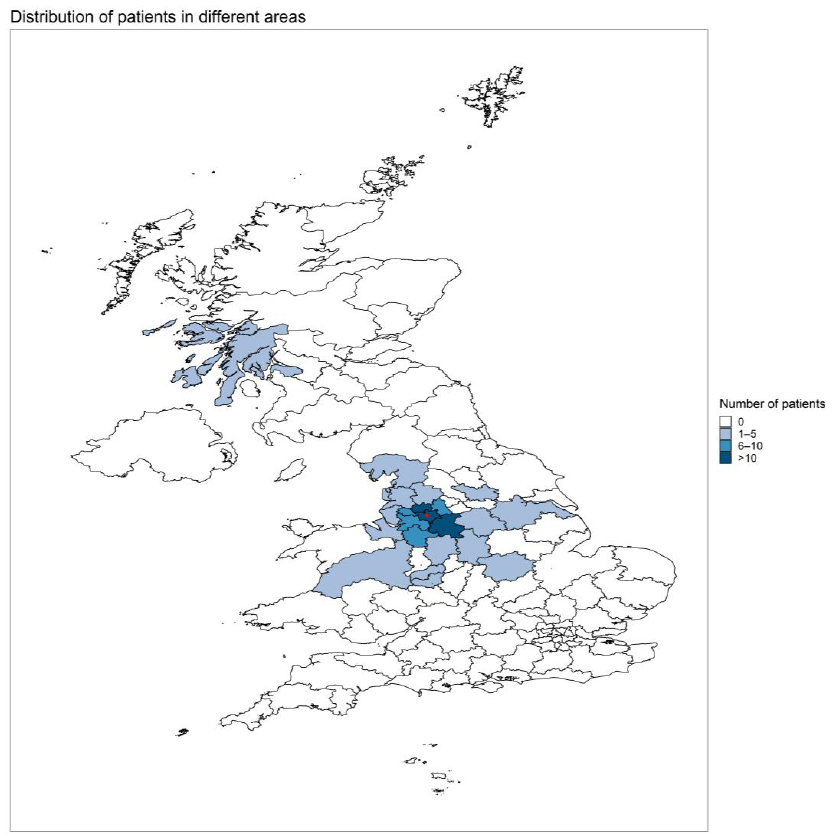
Figure 1. Map of the UK with the distribution of patients with AC receiving HPN under the care of the IF center. The red dot marks the location of the IF center. the IF center. The red dot marks the location of the IF